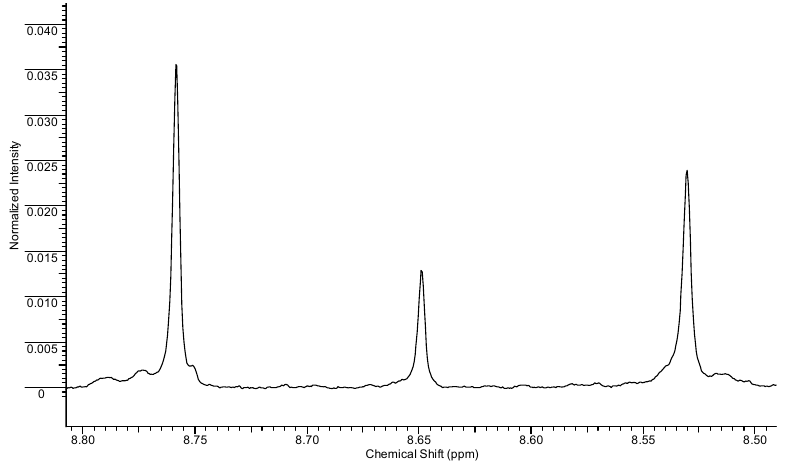
Figure 4. Spectral region between 8.50 and 8.80 ppm.